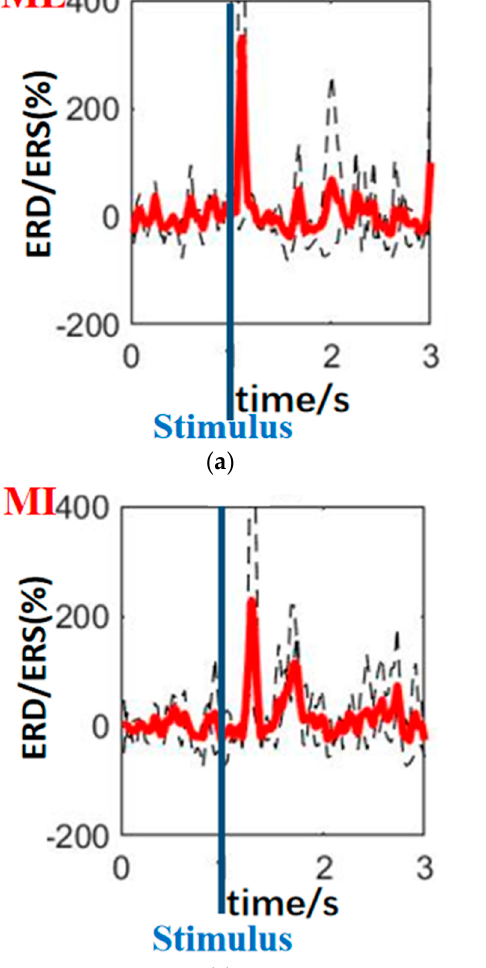
Figure 5. “Follow-up” pattern based on the beta rebound works as an indicator of ME and MI in amplitude, latency, duration, and distribution. An example of the time courses and topo-plots of ME (parts ( a , b )) and MI (parts ( c , d )) event-related desynchronization/synchronization (ERD/ERS) during the motion Tap: Right Finger 1. The bold red lines are the average across five subjects, while the dashed lines are the individuals’ ERD/ERS time courses at channel Cz. “Stimulus” marks the time when subjects hear the auditory instructions. Topo-plots are from subject S01 for motion Tap: Right Finger 1 at the time when the beta rebound is the most remarkable (ME: 1.624 s; MI: 1.818 s). Black dots mark the locations of electrodes. ERS is in red while ERD is in blue. Note that parts ( a , c ) are based on a part of our whole dataset (26.32%) to make the time courses more explicit for demon- stration.